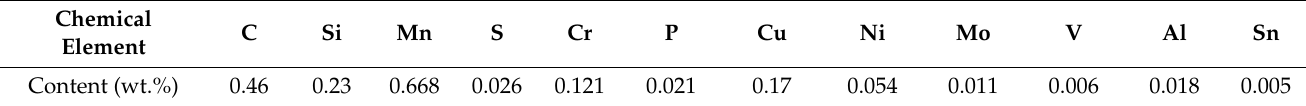
Table 1. Chemical composition of medium carbon steel C45E (Fe is